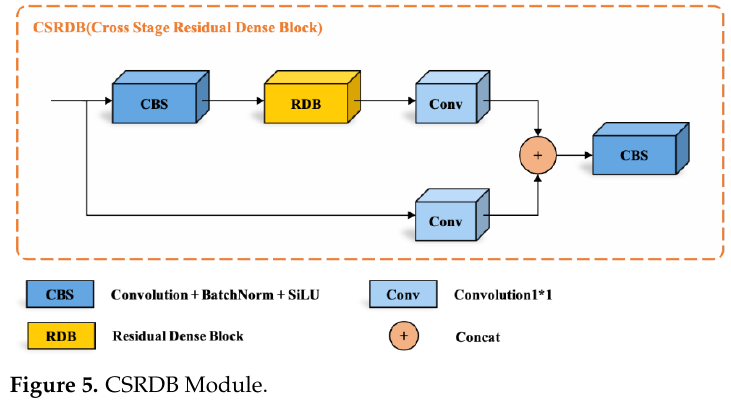
Figure 5. CSRDB Module.